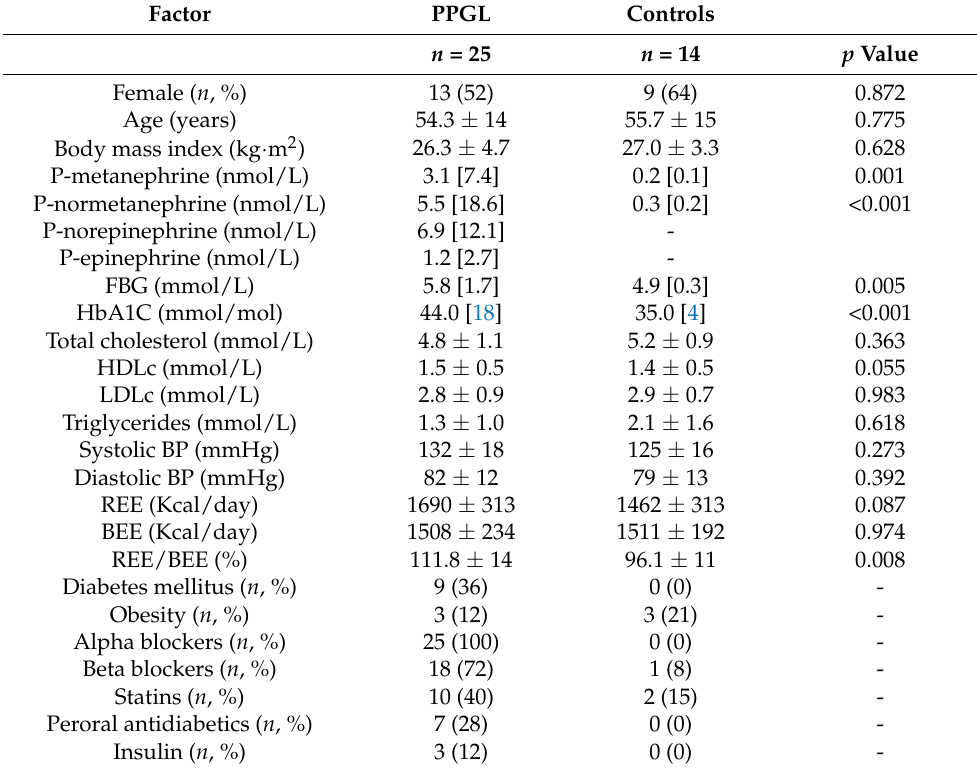
Table 1. Clinical and metabolic characteristics of study